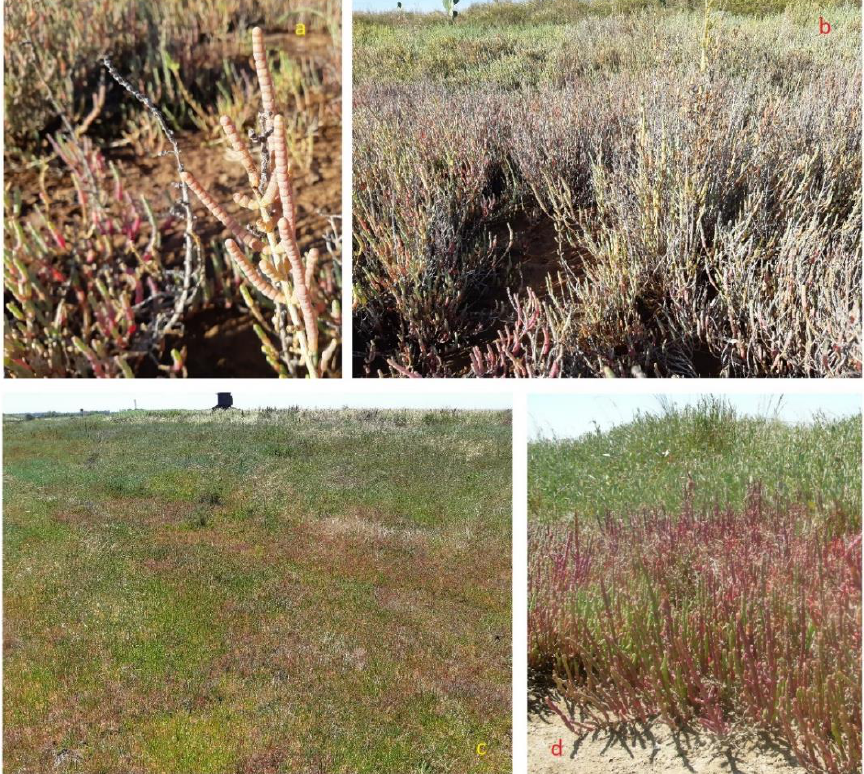
Figure 6. Salicornia fruticosa ( a , b ) at “Saline Margherita di Savoia” (FG, Northern Apulia); S. alpini ( c , d ) at “Saline di Punta della Contessa” (BR, Southern Apulia).